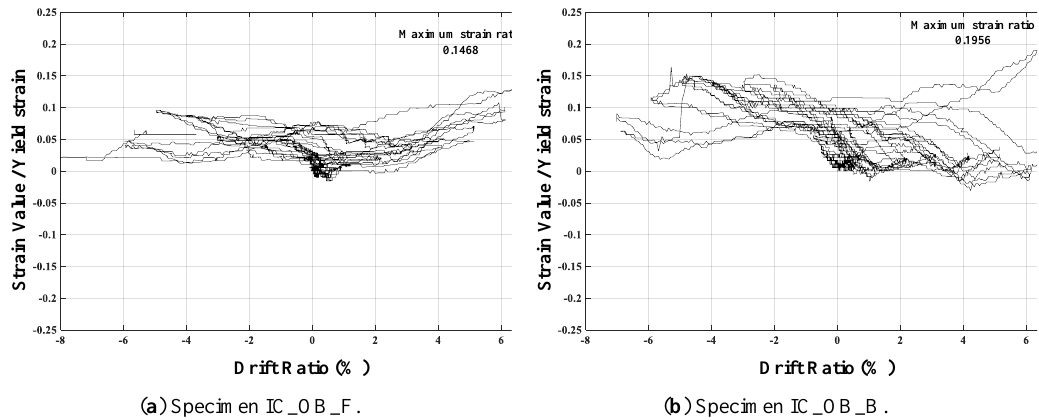
Figure 16. Principal strain of the connection plate measured by strain gauges No. 21 to 23.